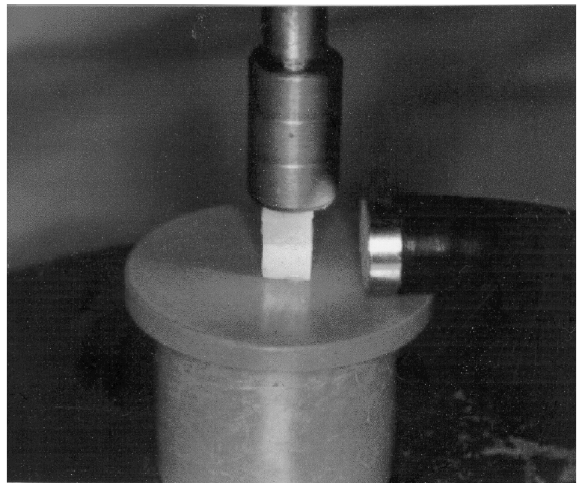
FIGURE 2- Blocks being luted on device for bonding